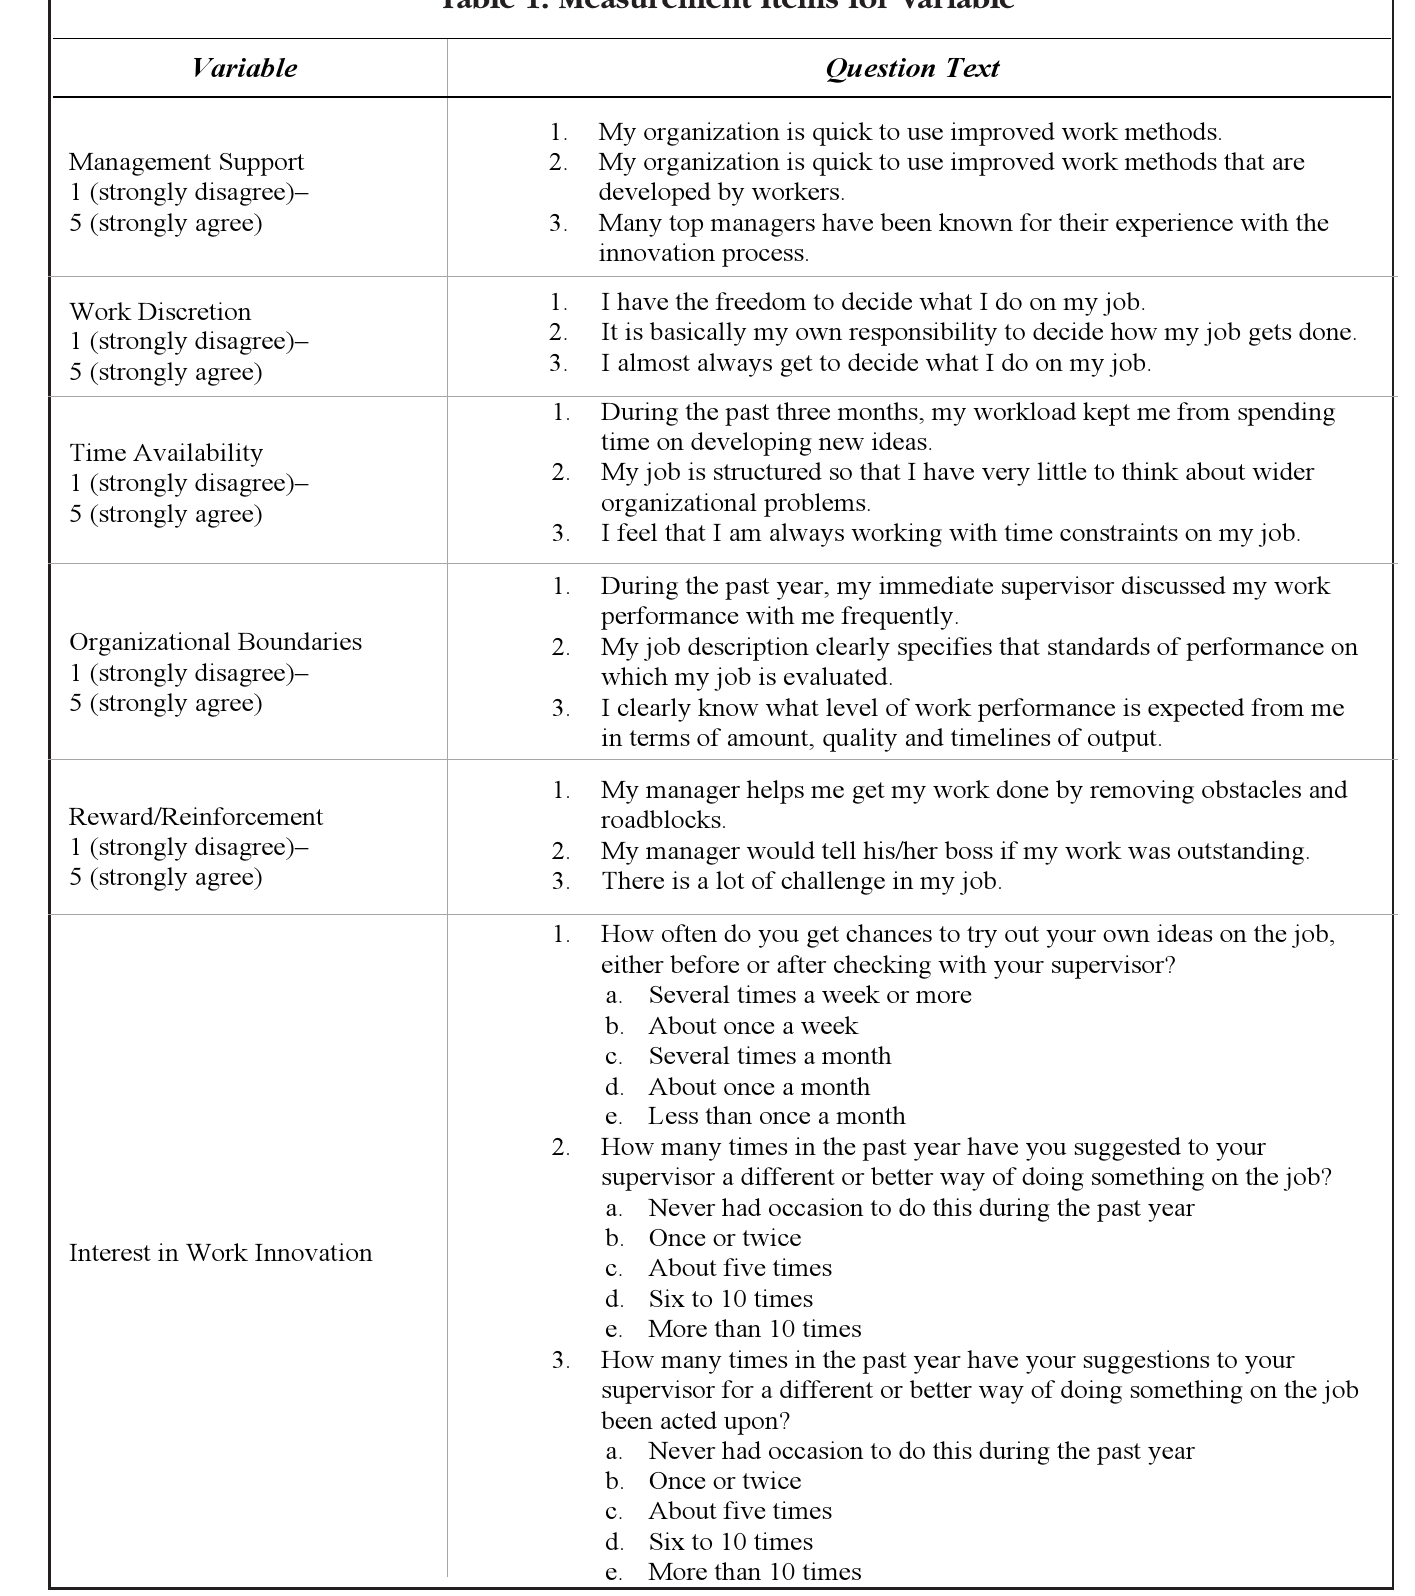
Table 1. Measurement Items for